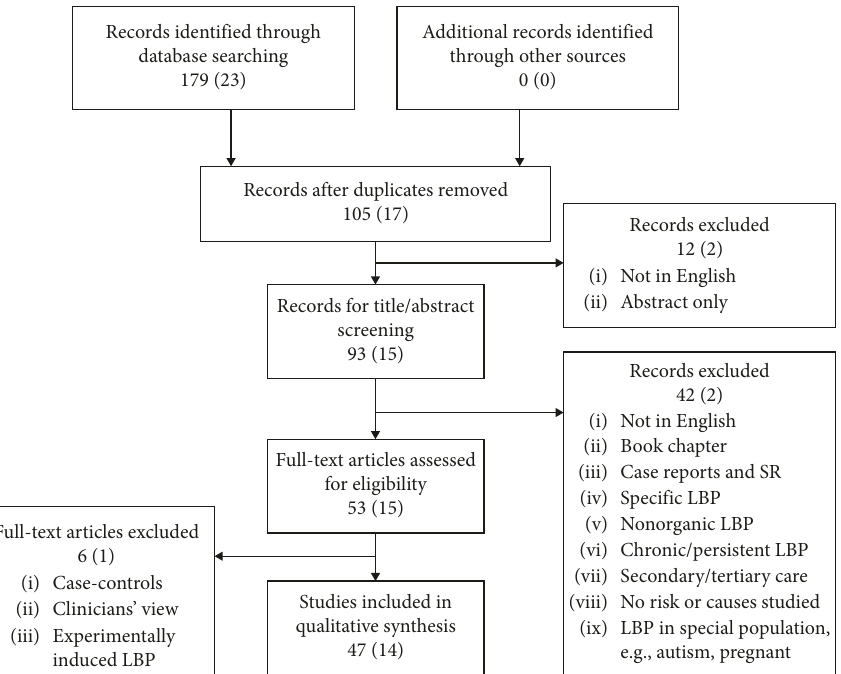
Figure 1: Flowchart of the search results (updated search results appeared in